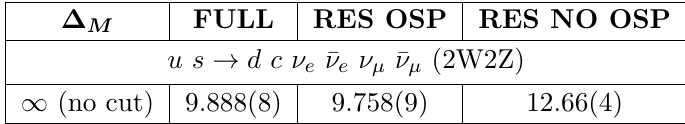
Table 6 . Cross sections ( ab ) for u s All diagrams are taken into account for the full calculation (FULL), while only double resonant diagrams contribute to the two rightmost columns, with (RES OSP) and without (RES NO OSP) projection. Selection cuts are: p j 300 GeV, M > 40 ‘ + ‘ (cid:0)